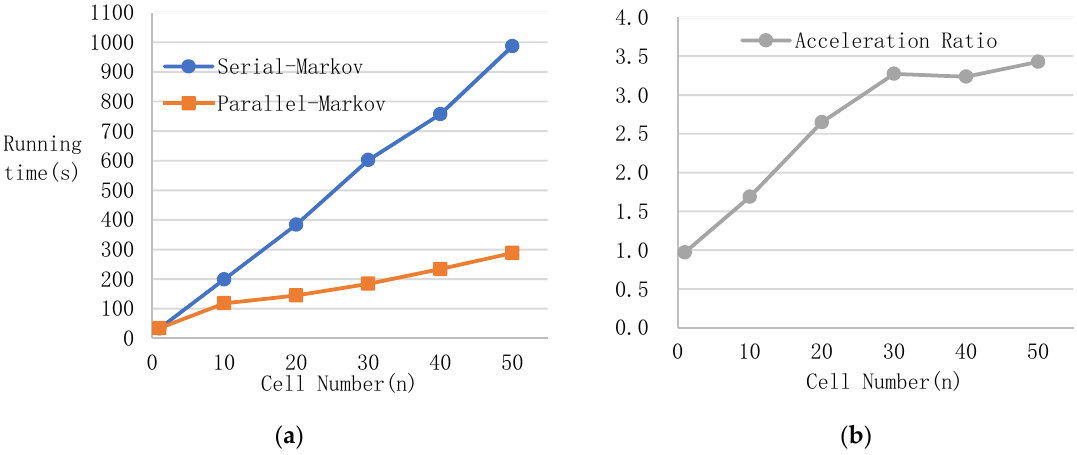
Figure 10. Running efficiency and acceleration ratio of Cloud-Markov relative to serial-Markov. ( a ) Running efficiency comparison, ( b ) acceleration ratio.